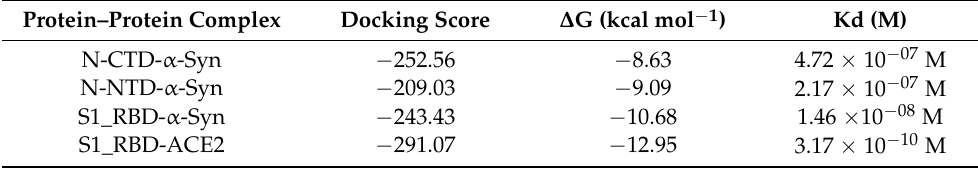
Table 1. Molecular docking of SARS-CoV-2 proteins to α -Syn determined by HDOCK server. Protein–Protein